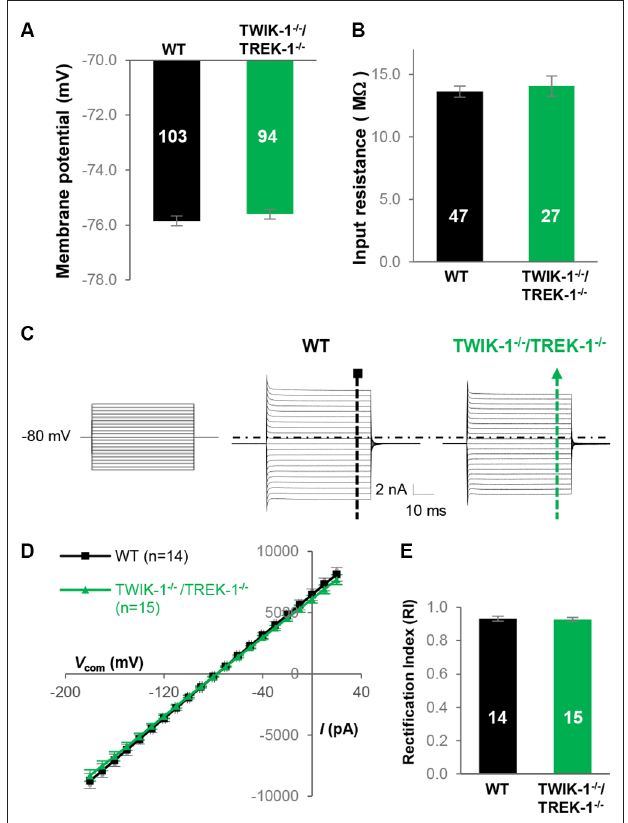
FIGURE 6 | K ir 4.1 inhibition does not reveal the functional contribution of TWIK-1/TREK-1 in double gene knockout mice. (A) Representative V M response to K ir 4.1 inhibitor, 100 µ M BaCl 2 , from a WT and a TWIK-1 − / − /TREK-1 − / − astrocyte as indicated in situ . (B) Summary of 100 µ M BaCl 2 -induced V M depolarization, where the V M depolarization was comparable between WT and TWIK-1 − / − /TREK-1 − / − astrocytes. (C) Representative whole-cell current recorded first in control, then 5 min in 100 µ M BaCl 2 , and washout. I–V relationships were shown in (D) . (D) I–V plots derived from recordings in (C) . The Ba 2 + -sensitive currents, in I-V plots were obtained from sweep subtraction. The Ba 2 + - sensitive currents were shown in expanded y -axis in the inset that showed a moderate inward rectification in both WT, RI = 0.91, and double gene knockout mice, RI = 0.90, respectively. (E) Summary of RI values from WT and TWIK-1 − / − /TREK-1 − / − astrocytes obtained from recordings in the presence of 100 µ M BaCl 2 for K ir 4.1 inhibition; the RI values were comparable between the two